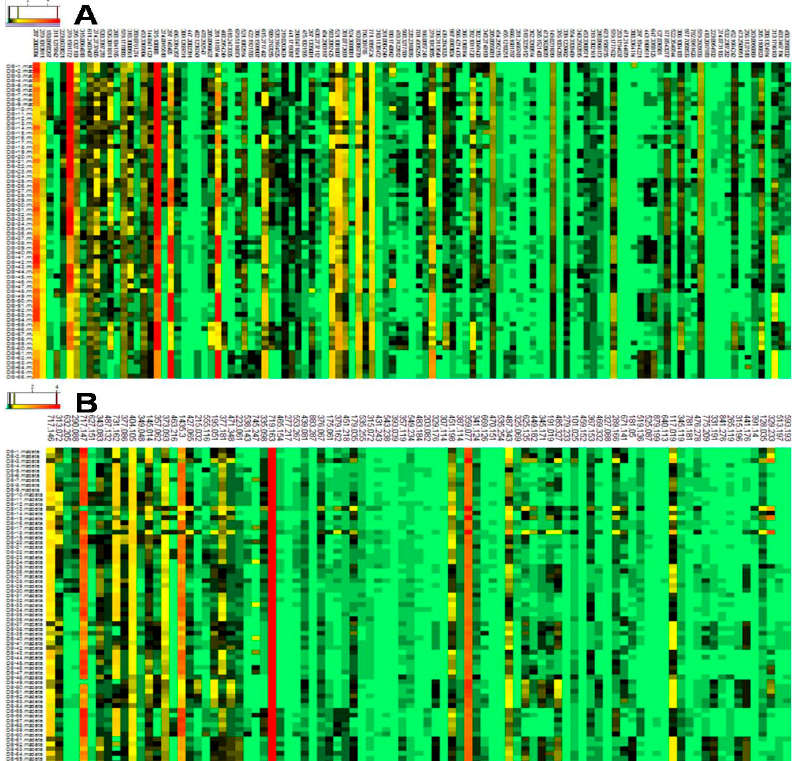
Figure 4. Heatmap analysis of the differential metabolites between the control and PSF treated S. miltiorrhiza hairy roots in positive ( A ) and negative ( B ) ion model of UHPLC-HRMS (axis of abscissas indicates the differential metabolites, axis of ordinates indicates the serial number of sample; red indicates high concentration levels of metabolites, yellow and black indicate medium concentration levels of metabolites, green indicates low concentration levels of metabolites).